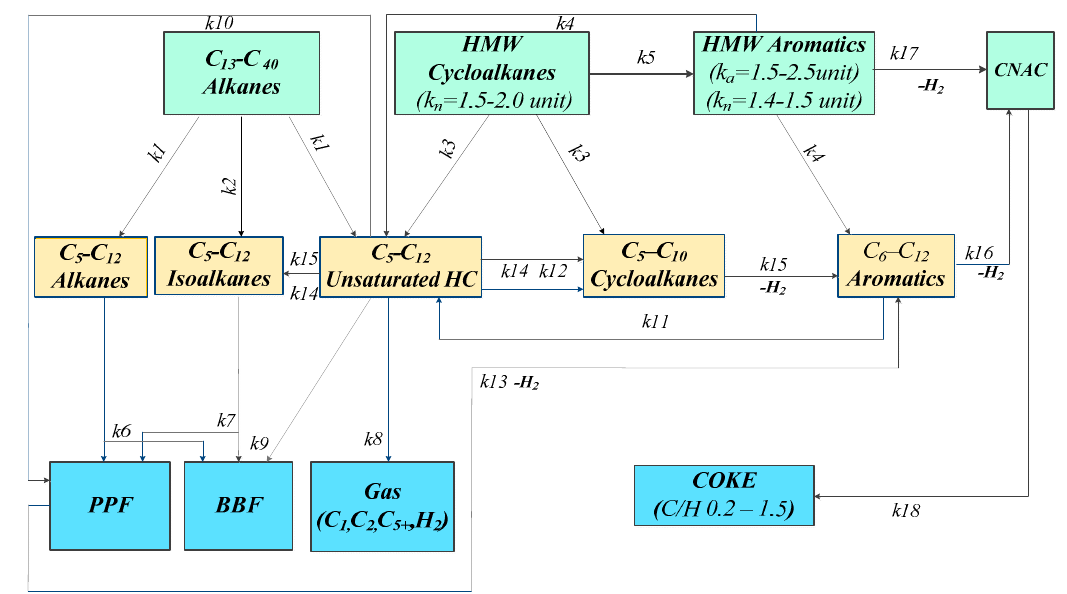
Figure 2. Kinetic scheme of catalytic cracking to predict the contents of the gasoline and the gas hydrocarbons as well as the coke: k is reaction rate constant; k n is the average number of naphthenic rings; k a is average number of aromatic rings; CNAC—condensed naphthenic–aromatic compounds: HMW—high molecular weight.